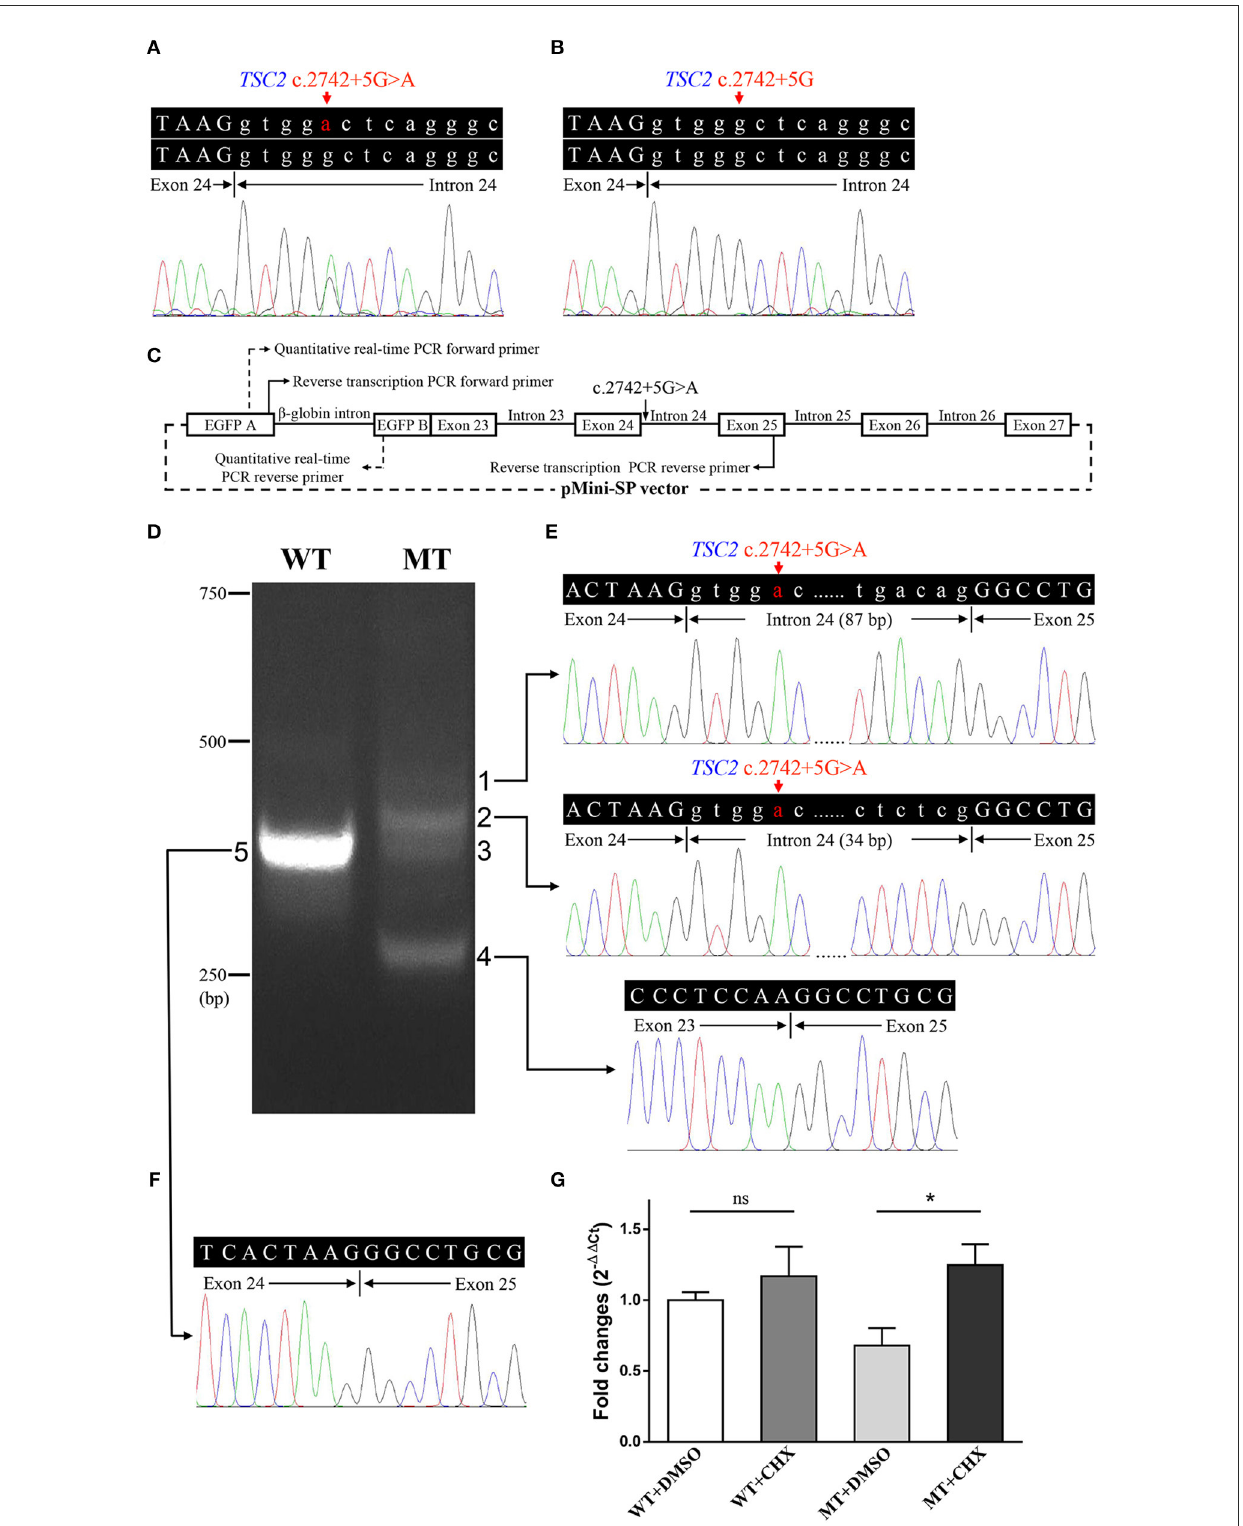
FIGURE3 Genetic analyses and minigene assay results of the TSC2 gene c.2742 + 5G > A variant. (A) Genomic DNA sequencing of heterozygous TSC2 c.2742 + 5G > A variant in the proband. (B) Genomic DNA sequencing of wild-type TSC2 gene in an unaffected member (II:1). (C) Minigene plasmids construction and primer sites. (D) The electrophoretic figure of the amplification products of cells expressing wild-type (WT) and mutant (MT) minigene plasmids. (E) Sequencing chromatogram of the amplification product of cells expressing mutant plasmid. Exonic sequences are shown in upper case, and intronic sequences are shown in lower case. (F) Sequencing chromatogram of the amplification product of cells expressing wild-type plasmid. (G) The relative levels of mRNA of wild-type (WT) and mutant (MT) minigene plasmids after dimethyl sulfoxide (DMSO) or cycloheximide (CHX) treatment (ns: not significant, * P <